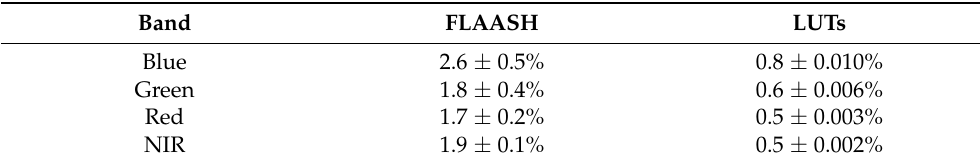
Table 8. Mean absolute errors for AC results provided by two AC methods compared with results given by 6SV